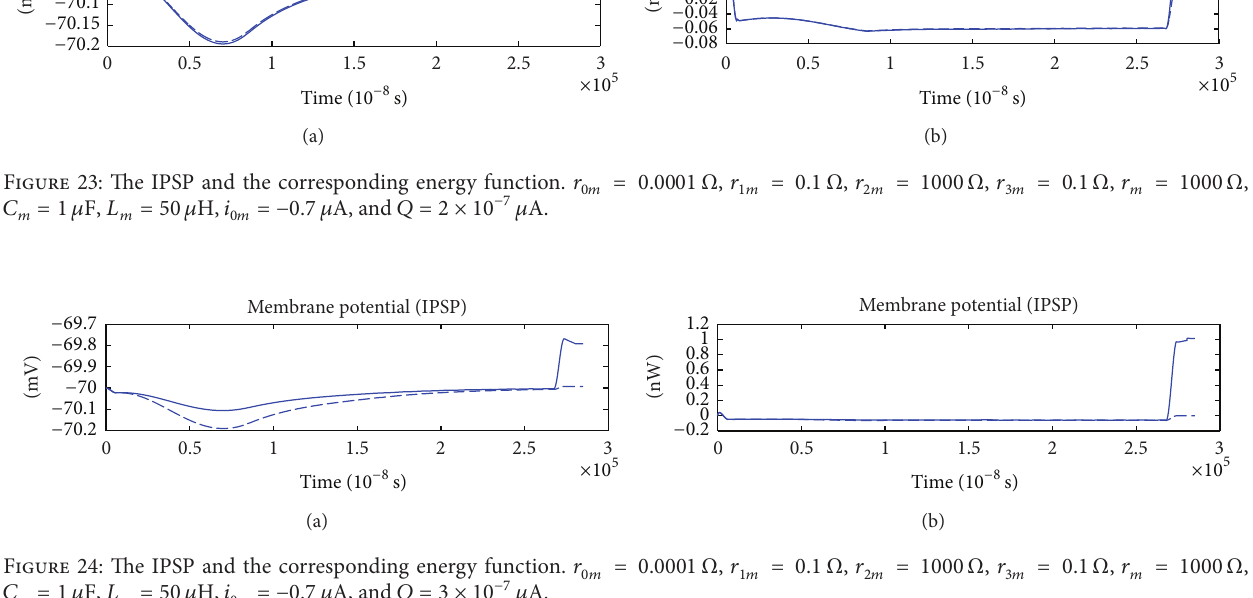
without noise. But the energy function with noise is slightly different from that without noise ranging between 1.5 ms and 2.5 ms